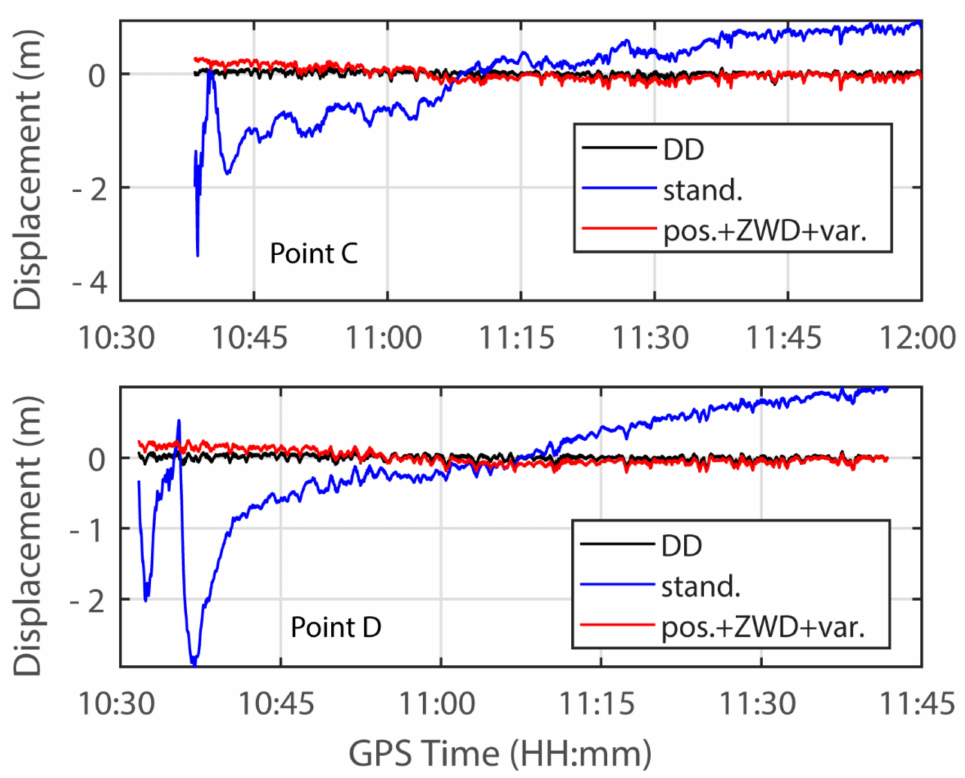
Figure A2. Comparison of position-constrained PPP and DD displacement time series after the data gap at point C (top panel) and Point D (bottom